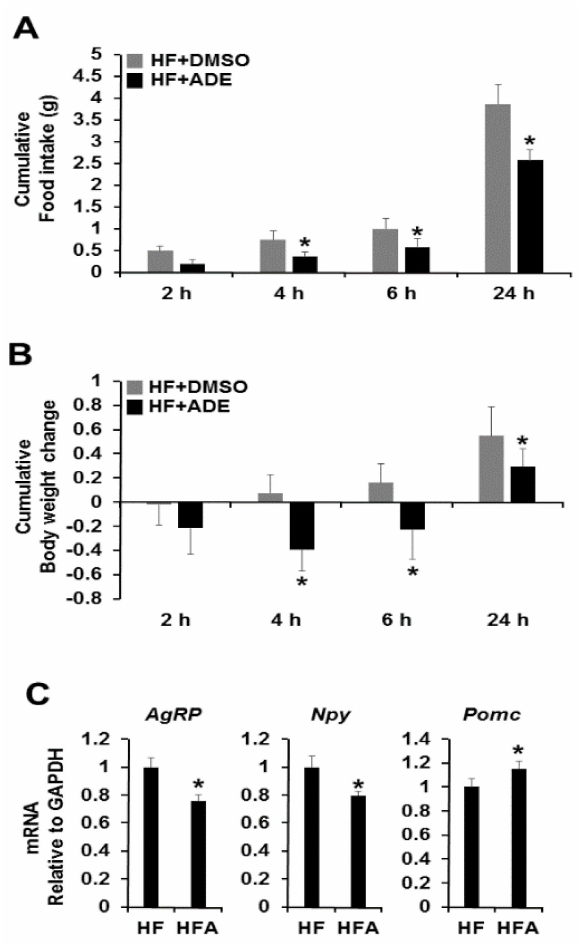
Figure 2. Effects of central administration of ADE on food intake and body weight. The average cumulative food intake ( A ) and body weight ( B ) were measured in high-fat-diet-induced mice ICV administration with ADE (1 µ L of 10 mg/mL) or DMSO (1 µ L of 20% DMSO) during the experimental period. The results are means ˘ SDs ( n = 10 per group); * p values of < 0.05 indicate significant difference from administration with DMSO (1 µ L of 20% DMSO). ( C ) Effects of ICV administration of ADE (1 µ L of 10 mg/mL) on hypothalamic mRNA expression levels of neuropeptides. The results are means ˘ SDs ( n = 10 per group); * p values of < 0.05 indicate significant difference from administration with DMSO (1 µ L of 20% DMSO). ADE, ethanol extract of Allomyrina dichotoma larvae. HF, high-fat diet with DMSO. HFA, high-fat diet with